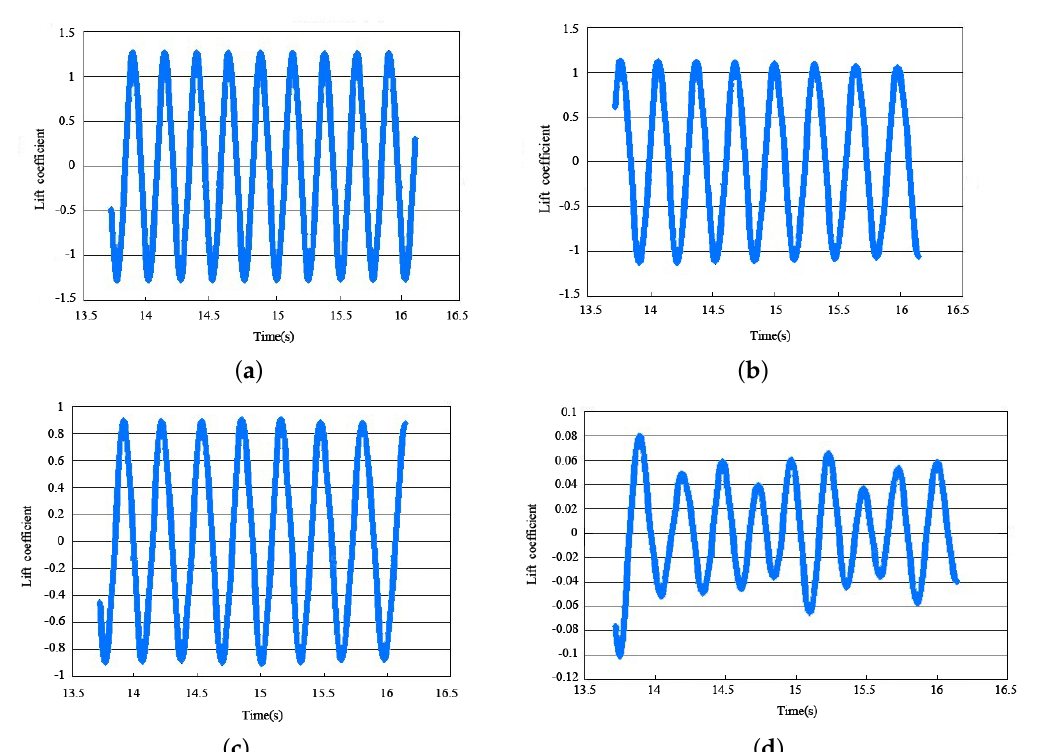
Figure 11. Variation curves of the lift coefficient of the SCR with time at different underwater depths: ( a ) lift coefficient curve at 1 m underwater; ( b ) lift coefficient curve at 2 m underwater; ( c ) lift coefficient curve at 3 m underwater; ( d ) lift coefficient curve of the entire riser.